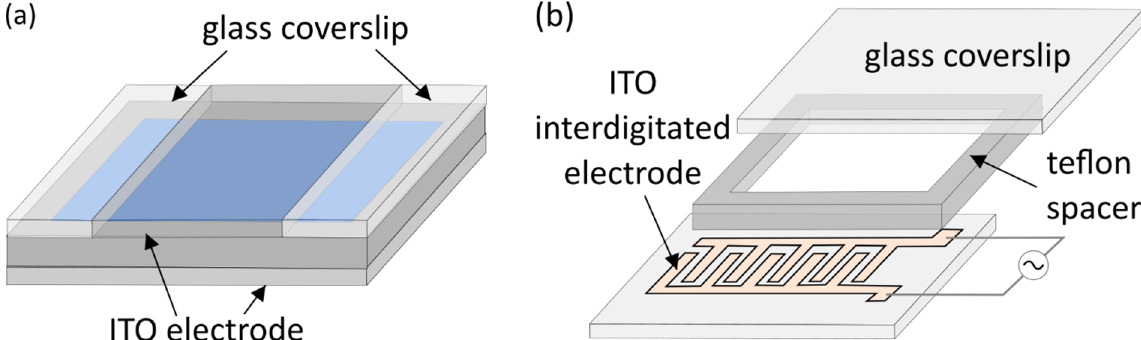
Figure 2. ( a ) Asymmetrical electrodes layout. The top indium tin oxide (ITO) electrode has a smaller surface than the bottom one, so it has to be surrounded by glass coverslips in order to close off the chamber. ( b ) Electroformation chamber with a coplanar interdigitated ITO electrode.